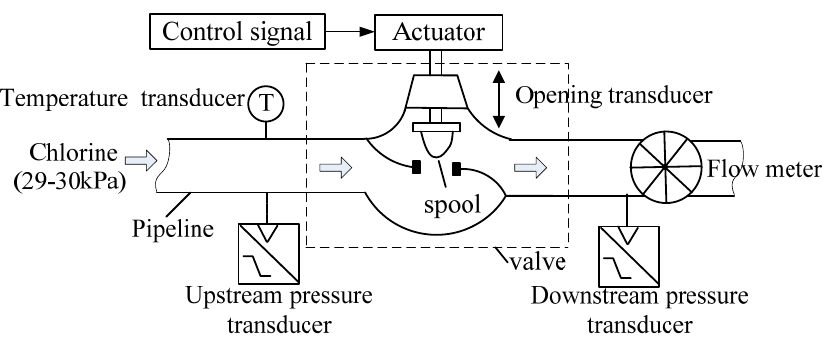
Figure 3. Diagram of chlorine pressure control system.